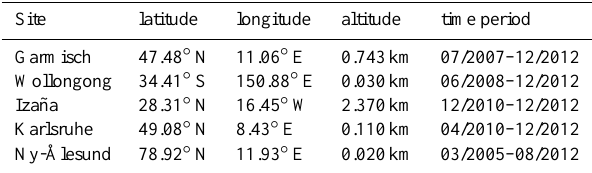
Table 1. The FTIR stations of this NDACC versus TCCON inter- comparison of XCH 4 , along with geographical coordinates and the time period of FTIR measurements